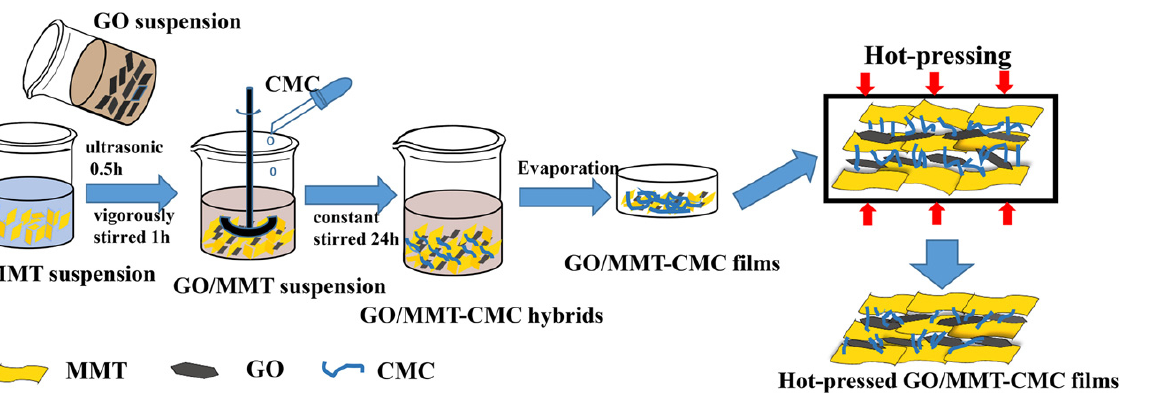
Figure 9. The preparation process of ternary mimic − nacre flame − retardant coating based on gra- phene oxide/montmorillonite − carboxymethycellulose (GO/MMT − CMC) nanocomposite through evaporation assembly and hot pressing. Reprinted with permission from Ref. [63] Copyright 2019 Elsevier.